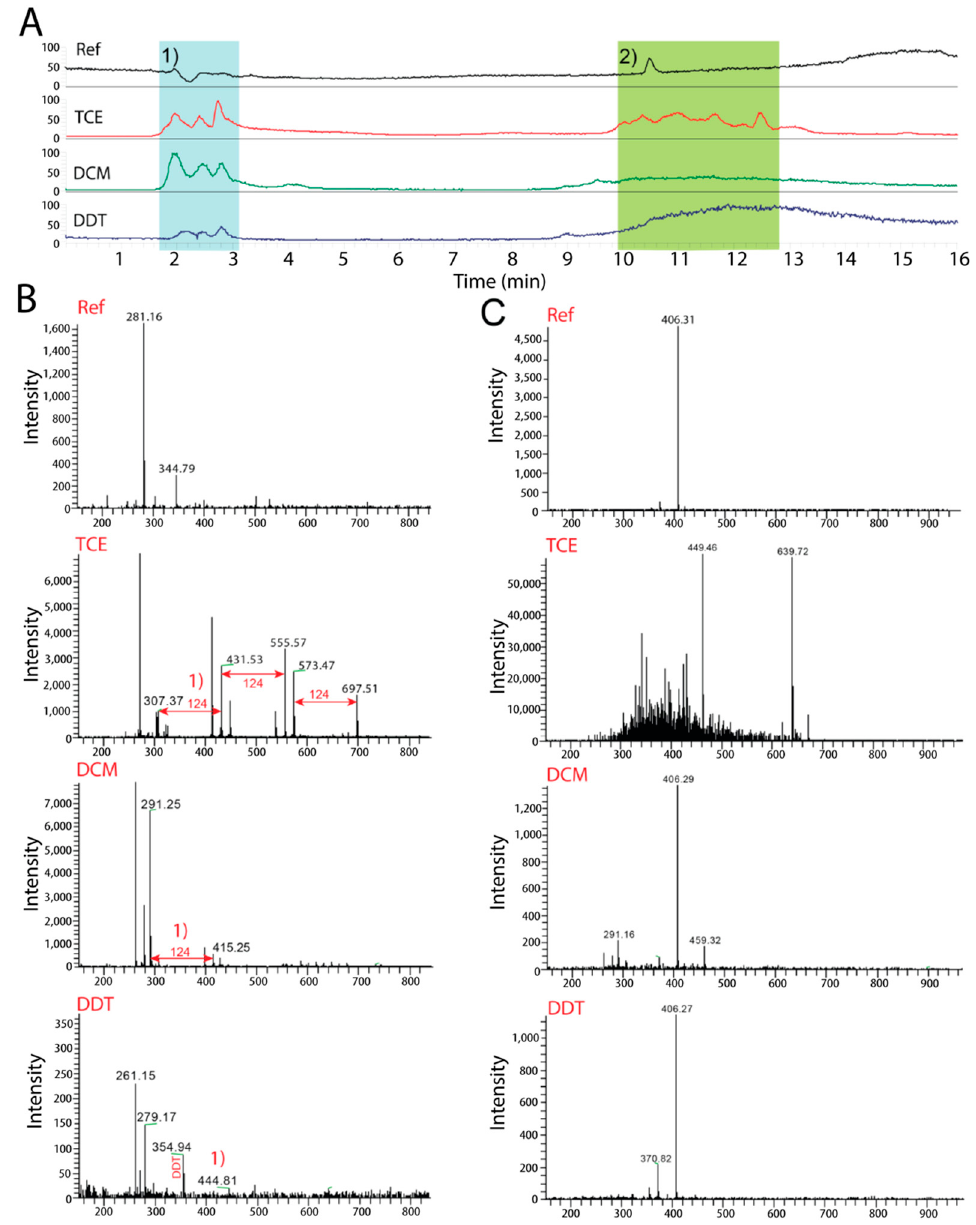
Figure 2. LC/MS data of the mixture of DBN and organochlorides. ( A ) LC chromatograms of the reference (DBN) and its mixture with organochlorides. ( B ) MS spectra from the short retention time (blue region) and ( C ) MS spectra from the long retention time (green region). The unit of the horizontal axis is m / z .